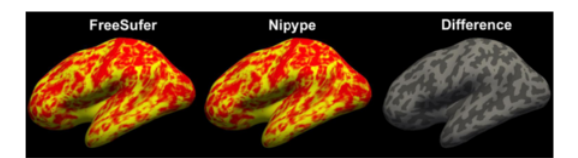
Fig. 13 (abstract A15). Visualization of the cortical thickness projected onto the left hemisphere's inflated surface for both the FreeSurfer(left) and Nipype workflows as well as the difference the two thicknesses(right). The thickness measurements showed no difference between the